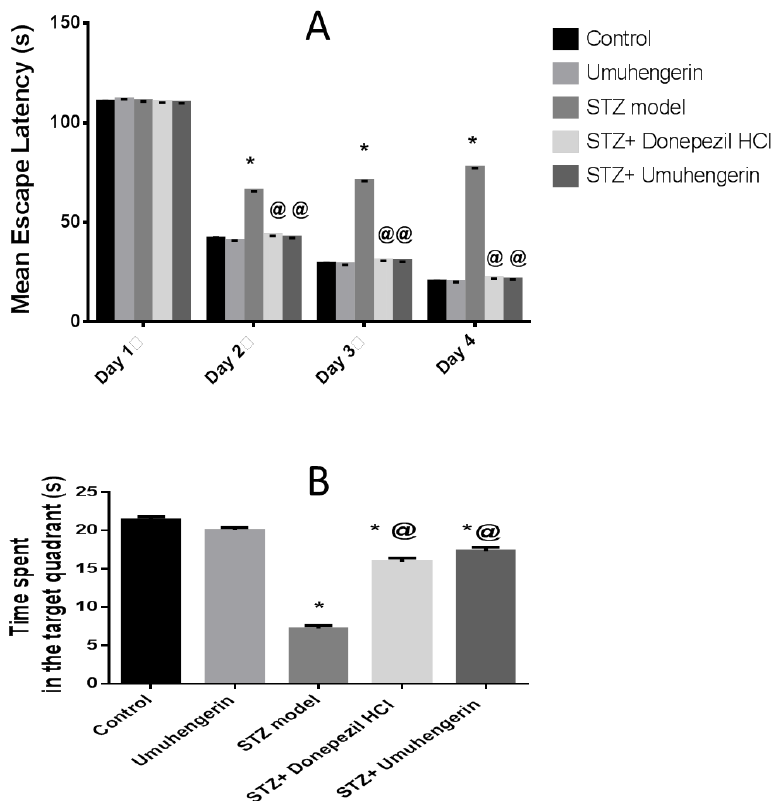
Figure 2 . Effect of umuhengerin on the behavior of the animals receiving STZ during the Morris water maze test. ( A ) Mean escape latency (MEL) and ( B ) the time spent in the target quadrant. Values are expressed as mean ± SEM; n = 10. * p < 0.05 vs. control group, @ p < 0.05 vs. ICV-STZ group .